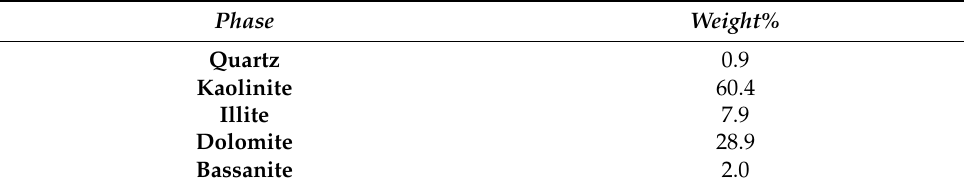
Table A3. Results of the LTA (low-temperature ashing) XRD.